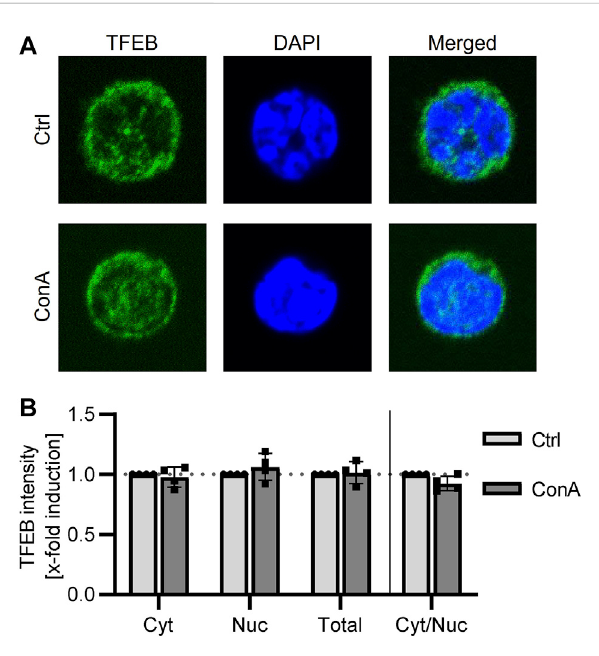
FIGURE 2 TFEBlocationisnotalteredbyConAtreatmentinmurinePBMCs. PBMCs from young mice were treated for 2 h with 100 nM of ConA at 37 ° C. (A) Representative immuno fl uorescentstaining forTFEB (green), DAPI (blue) and merged channels in Ctrl and ConA treated PBMCs. (B) ConA treatment did not change cytosolic, nuclear, total TFEBintensityortheratioofcytosolictonuclearTFEBsignalofmurine PBMCs ( n = 4). Data represent mean ± SD. Statistical signi fi cance was tested with one sample Wilcoxon